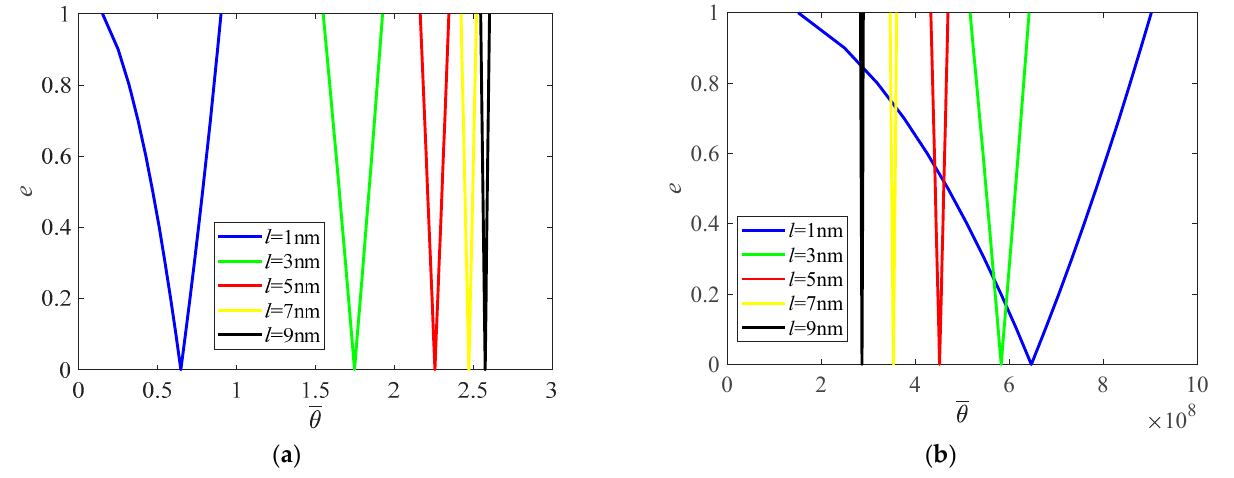
(cid:112) (cid:112) ρ / E ; ( b ) θ = θ ρ / E . (cid:112) ρ / E ,